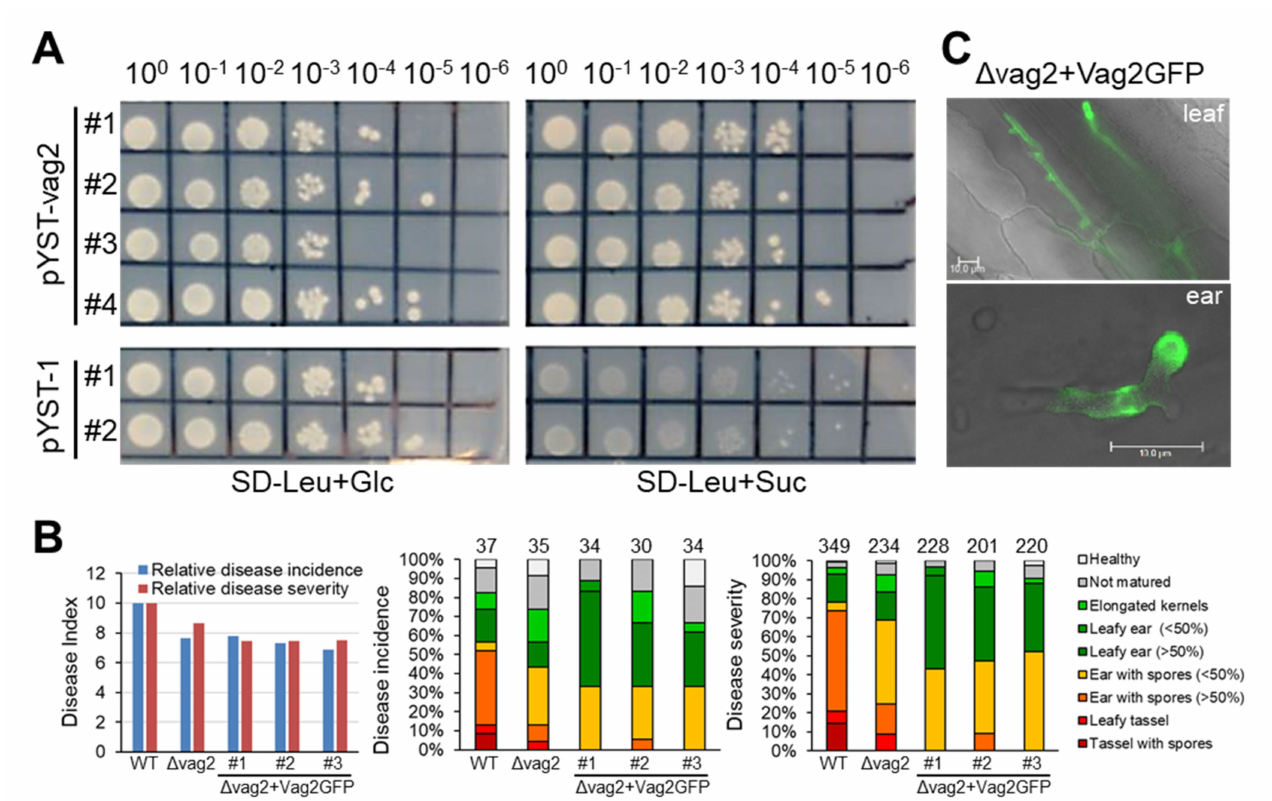
Figure 4. Vag2 contains a secretion signal peptide, but a Vag2-GFP Fusion is not functional. ( A ) Yeast secretion trap assay confirms the predicted secretion signal peptide of Vag2. Saccharomyces cerevisiae SEY6210 was used for transformation with the empty vector containing the SUC2 gene and lacking the N-terminal sequences encoding the secretion signal peptide (pYST-1), or with the pYST-1 vector containing the Vag2 open reading frame in fusion to the SUC2 gene of pYST-1 (pYST-vag2). Serial dilutions of different transformants were plated on SD minimal medium lacking leucine but con- taining glucose (SD-Leu + Glc) as growth control, and on SD minimal medium lacking leucine but containing sucrose (SD-Leu + Suc) as a test. Only strains containing vag2 were able to use sucrose as a carbon source. ( B ) A Vag2-GFP fusion does not complement the lack of Vag2 during maize colonization by S. reilianum . Seedlings of Z. mays cv. ‘Gaspe Flint’ was used for inoculation with combinations of mating-compatible wild-type strains (WT), strains lacking vag2 ( ∆ vag2), or